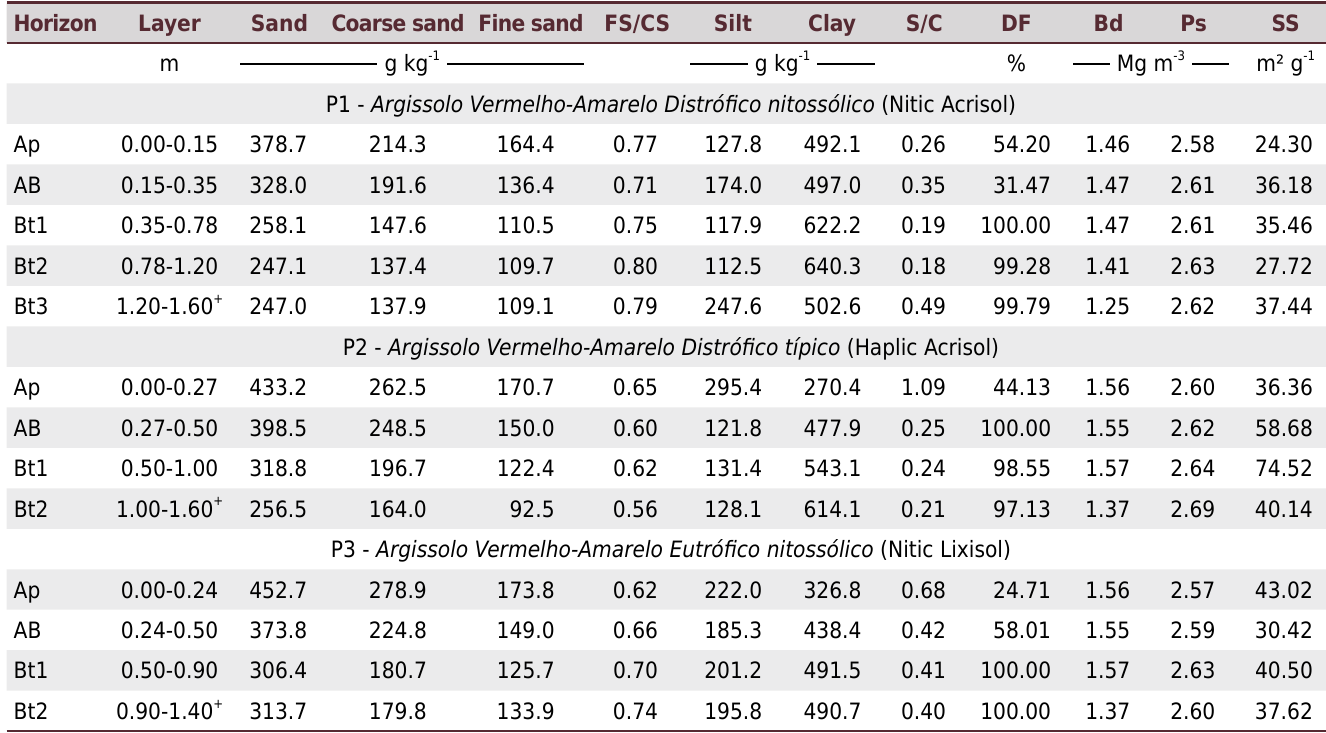
Table 2. Physical properties of soils in a topographic sequence, São Vicente Férrer, Pernambuco, Brazil Horizon